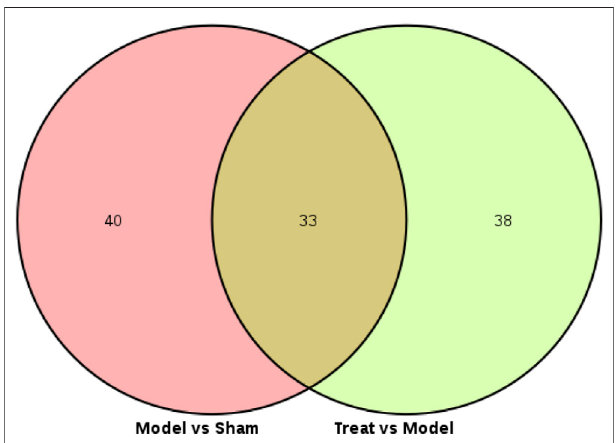
FIGURE 7 | Venn diagram of every differential metabolites between the Model VS. Sham and Treat VS. Model.